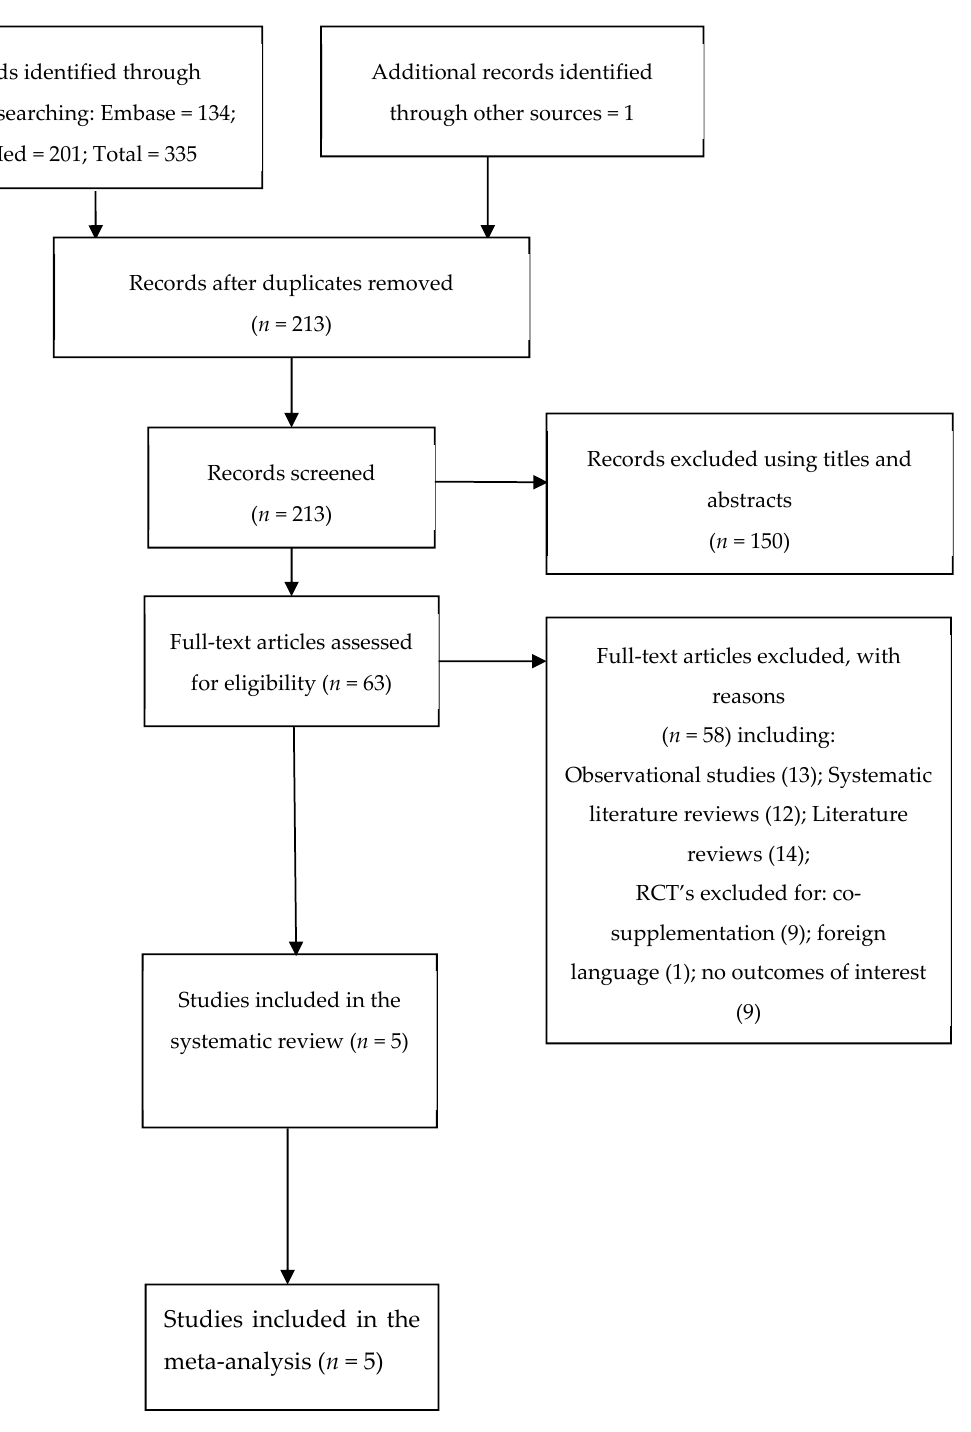
Figure 1. Preferred reporting items for systematic reviews and meta-analyses (PRISMA) study selection.